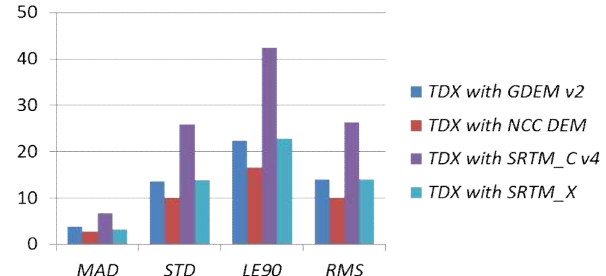
Figure 4: Accuracy assessment of TDX DEM products generated with different height references according